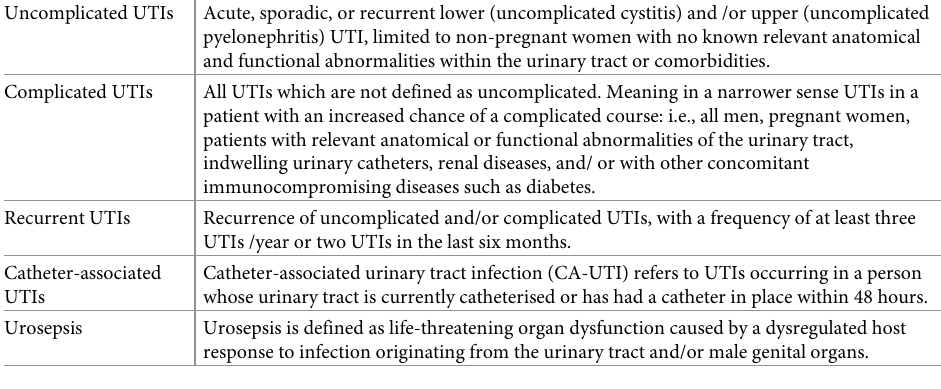
Table 1. Classification of